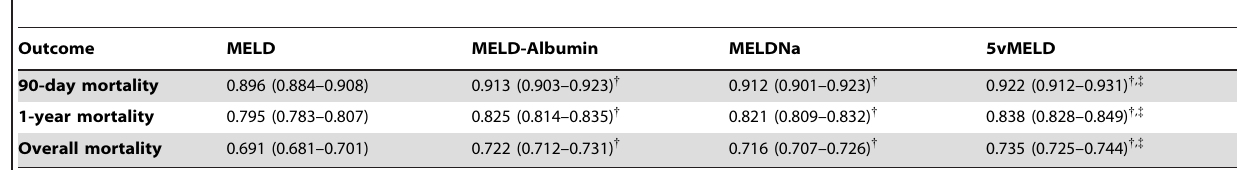
*Analyses restricted to 15,114 patients from validation cohort with complete laboratory data. { P , 0.001 compared to